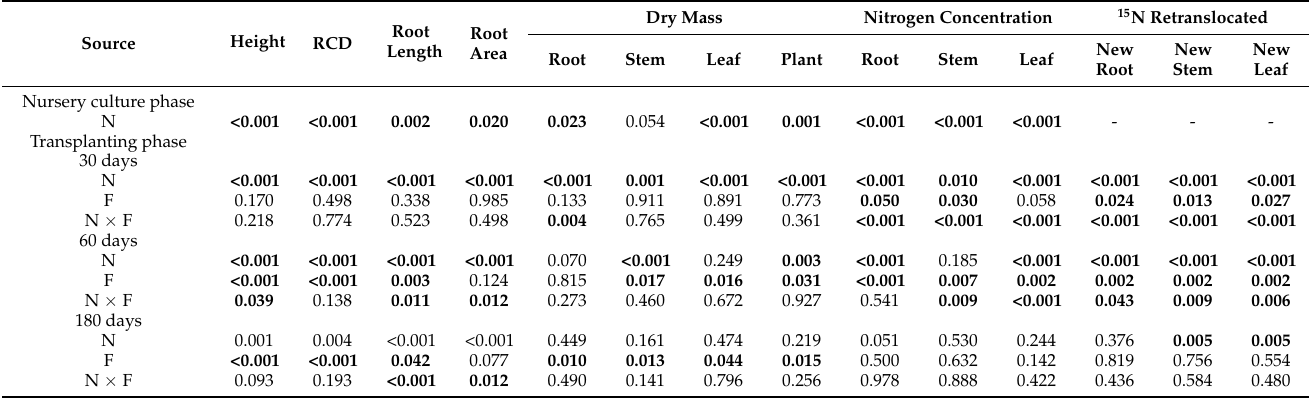
Table 3. ANOVA results of nutrient loading (N) and subsequent effects of N and fertilization at transplanting (F) on Betula alnoides growth, nitrogen concentration, and 15 N retranslocated into new